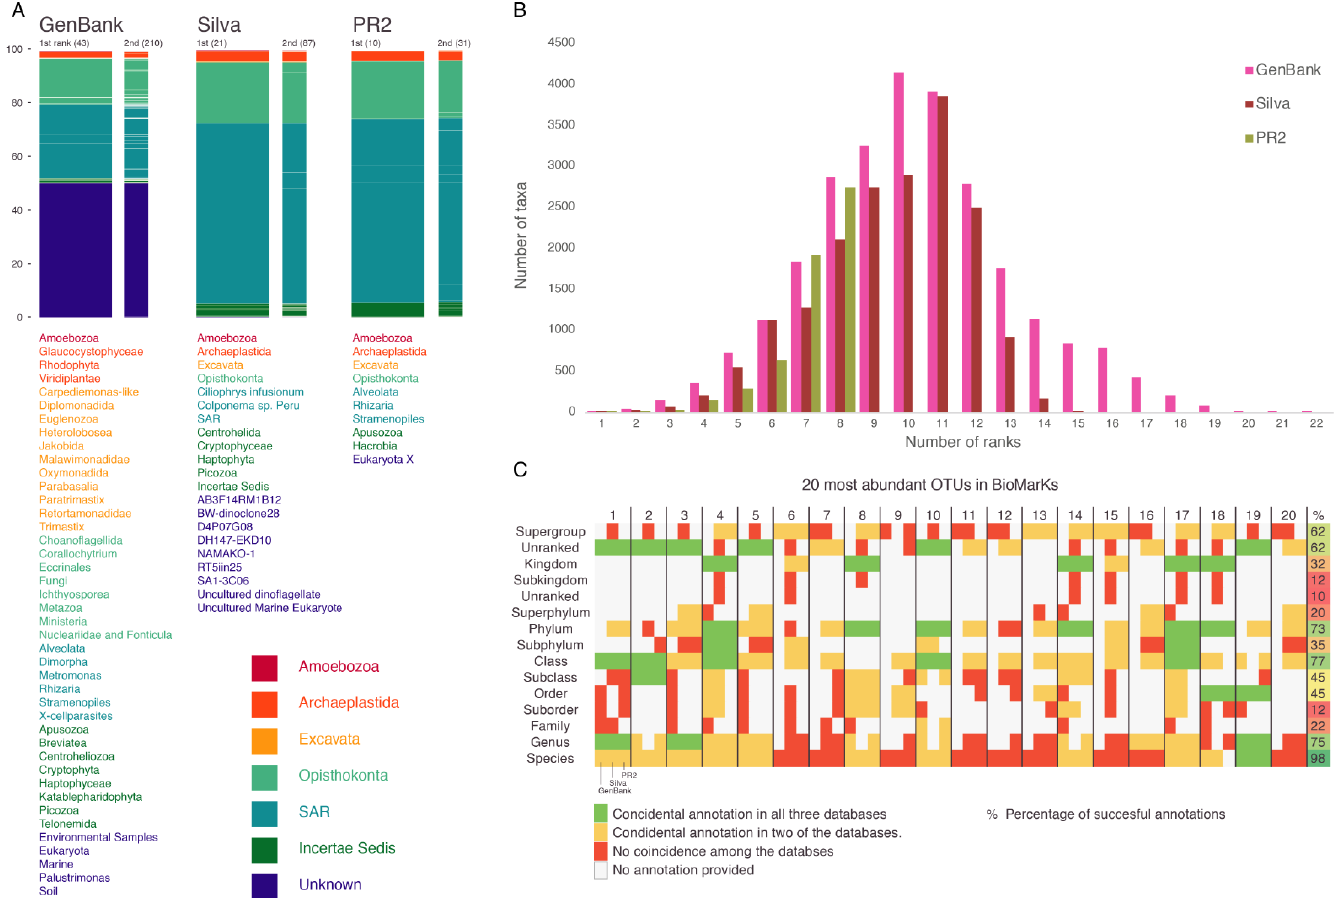
Fig 1. Comparison of existing databases. (A) Bar plots of taxonomic annotations of BioMarKs environmental sequences using the most popular reference databases for annotating 18S rRNA gene datasets for protist metabarcoding analyses (INSDC GenBank release 215, SILVA version 123.1, and PR 2 version 4.2) at the first (level just below Eukarya) and second taxonomic ranks. White spaces in the boxes mark the changes between second-level ranks. Taxon names for the first rank in each database are listed below the bar plot. On top of each bar plot, within brackets, we show the number of taxa per rank. The taxon names for the first rank and bar plots are colored based on the eukaryotic supergroups defined by Burki 2014 [16]. (B) Distribution of the number ranks assigned to terminal taxa (unique taxonomic strings) in the three databases. (C) Taxonomic agreement on the annotation of the 20 most abundant OTUs within BioMarKs using each database, listed on x-axis as GenBank, SILVA, and PR 2 . Full taxonomic annotation available in S1 Table. INSDC, International Nucleotide Sequence Database Collaboration; OTU, operational taxonomic unit; PR 2 , Protist Ribosomal Reference Database; SAR, Stramenopiles, Alveolates, and Rhizaria; 18S rRNA, small subunit ribosomal DNA.